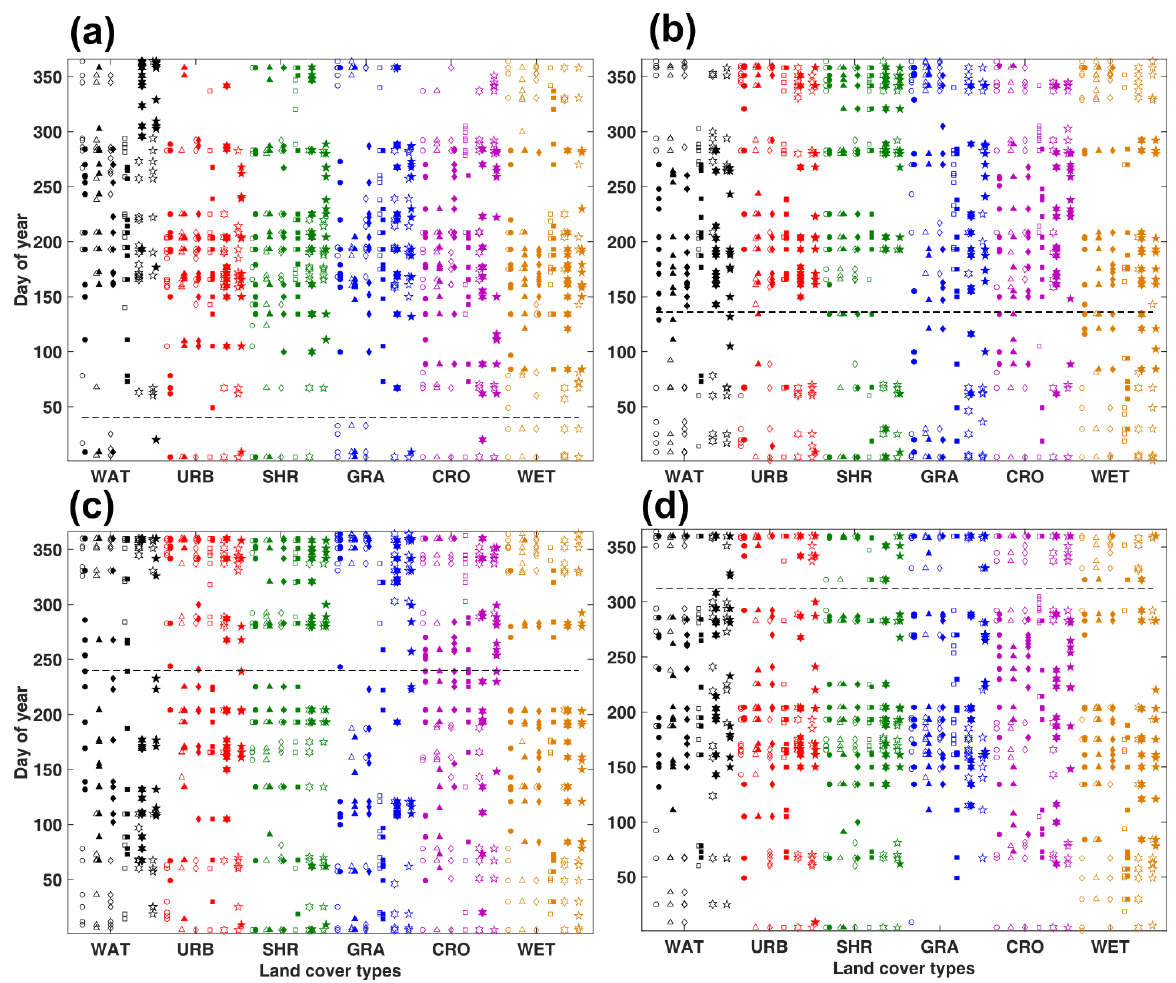
Figure 4. Distribution of the day of year (DOY) for minimum R 2 (not filled marker) and maximum RMSE (filled marker) value at each year from 2001 to 2012. The corresponding base date (dash line) is ( a ) 9 February (DOY: 40), ( b ) 16 May (DOY: 136), ( c ) 28 August (DOY: 240) and ( d ) 8 November (DOY: 312) for year 2001,